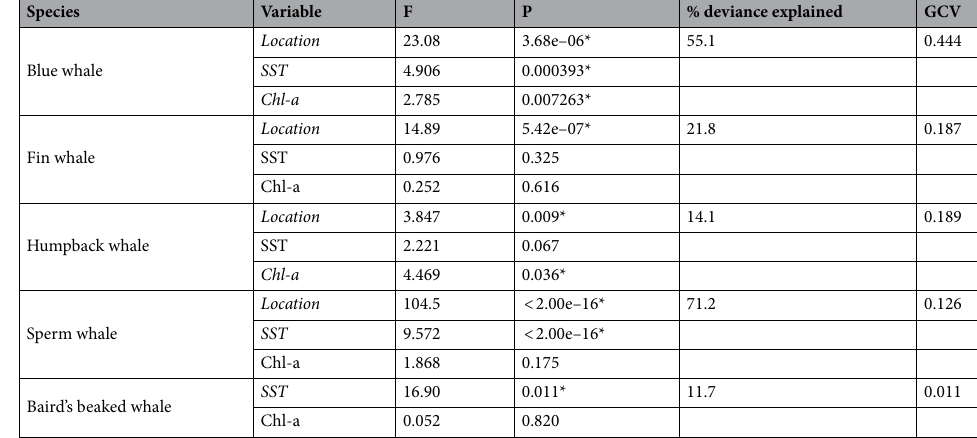
Table 2. Results of the generalized additive mixed models (GAMMs) of the effect of environmental parameters and location on the proportion of hours with whale calls. For each whale species, F-ratios and P-values for each of the three variables (location, SST, and chl-a) are presented, as well as percent deviance explained by the model and generalized cross-validation (GCV) score. Variables with significant P-values (marked with an asterisk) are